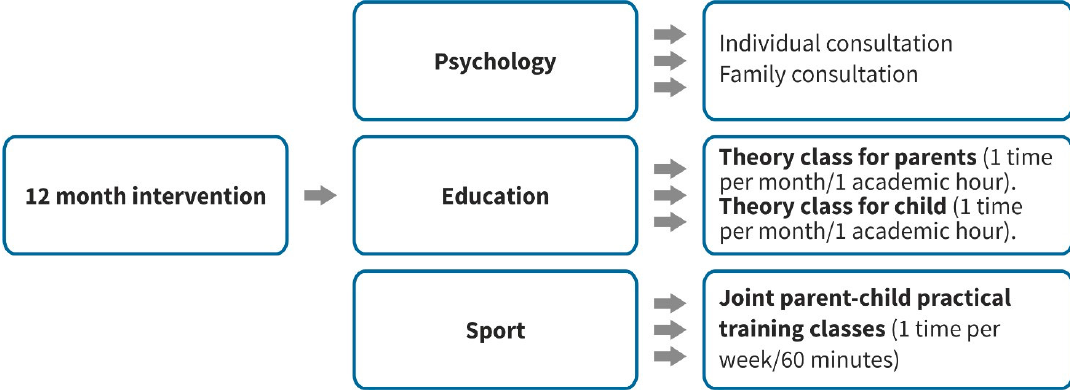
Figure 1. Parental involvement in a youth sport intervention program.